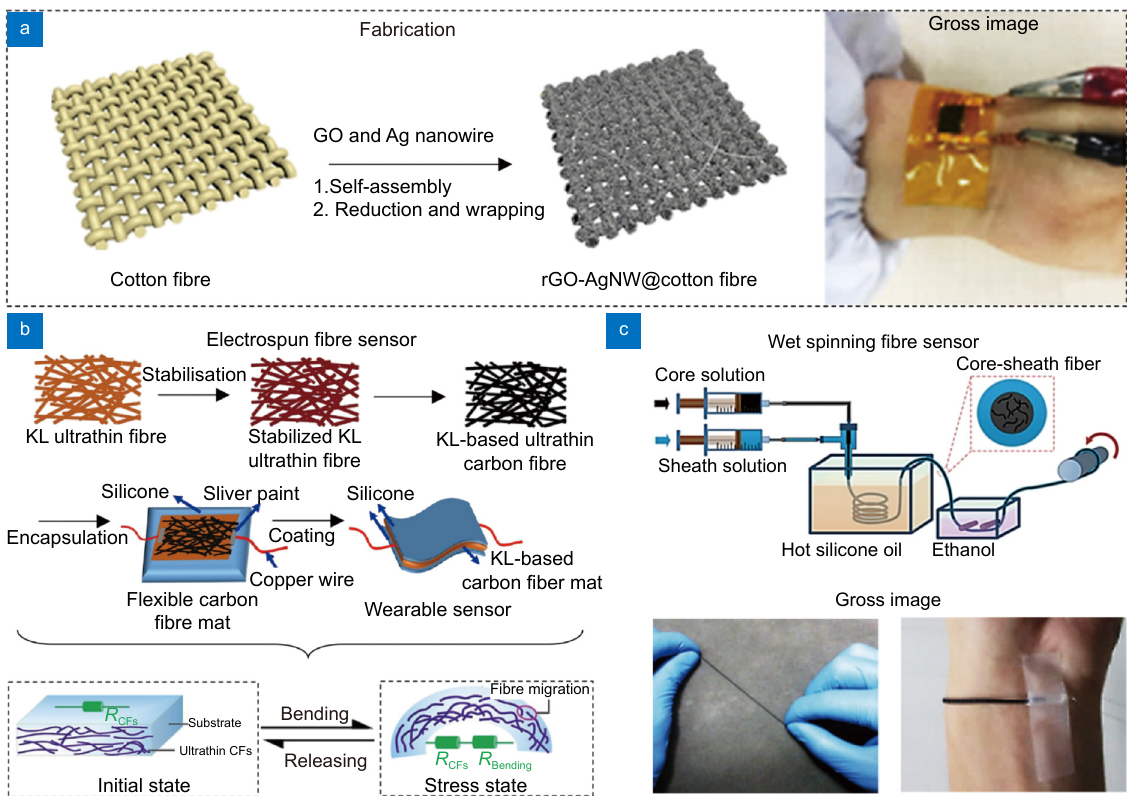
Fig. 7 | Design and manufacture of fibre piezoresistive sensor. ( a ) Schematic of a rGO-Ag NW@cotton fibre, through immersion of cotton fibres in a reductive solution containing GO and AgNW 112 . GO, graphene oxide; rGO, reduced GO; and AgNW, Ag nanowires. ( b ) Scheme of an electrospun fibre piezoresistive sensor and its sensing mechanisms during pressure and blending 110 . KL, kraft lignin. ( c ) Scheme of a wet-spin- ning single-fibre piezoresistive sensor 122 . Figure reproduced with permission from: (a) ref. 110 , (b) ref. 112 , Elsevier; (c) ref. 122 , American Chemical